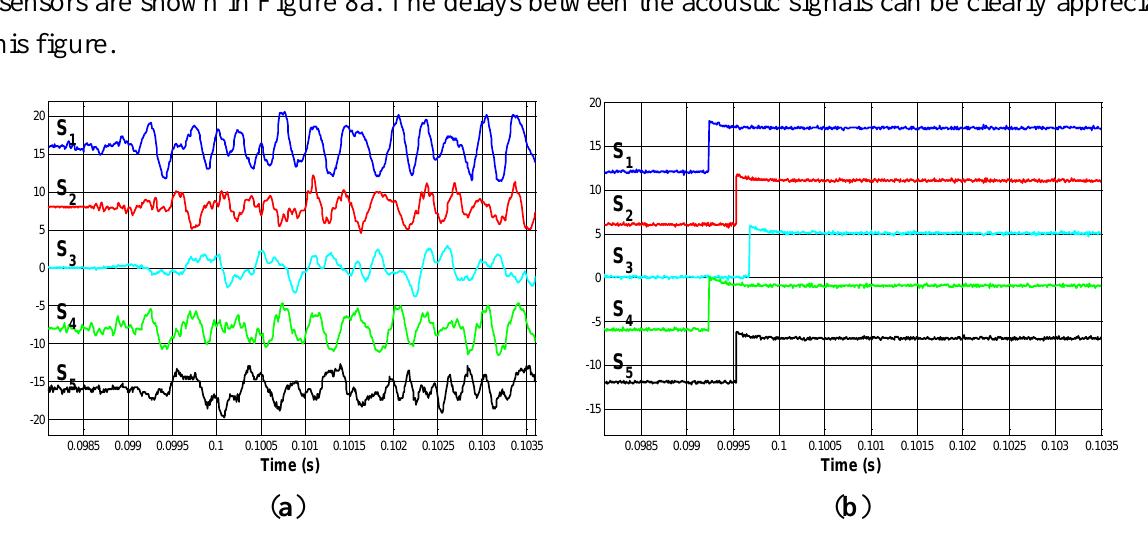
Figure 8. ( a ) Impact on 𝑃_1 . Detailed view; ( b ) Edge signals when impacting on 𝑃_1